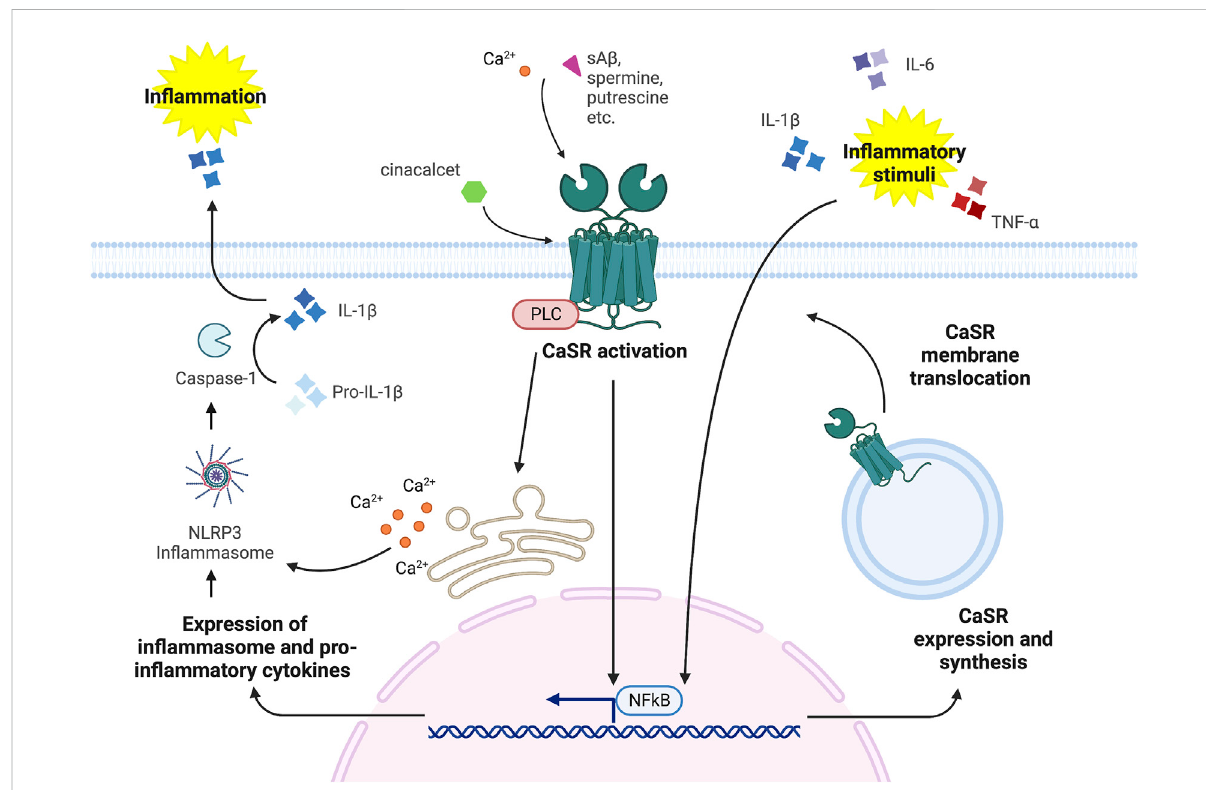
FIGURE 2 CaSR-In fl ammation signaling cross-talk ( fi gure drawn with Biorender.com, accessed on 27 October 2022). CaSR stimulation via orthosteric ligands, such as Ca 2+ , spermine, spermidine, putrescine, etc. and allosteric modulators, such as cinacalcet and NPS R-568, induces the activation